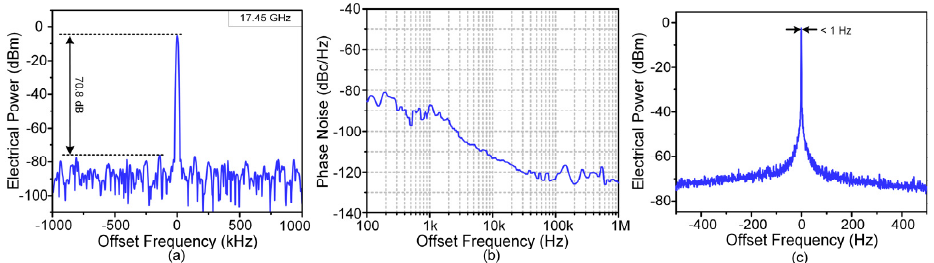
Figure 8. The results of the stabilized 17.45 GHz signal [38]. ( a ) Electrical spectrum; ( b ) traces of microwave frequency drifts in 20 min; ( c ) SSB phase noise spectrum.